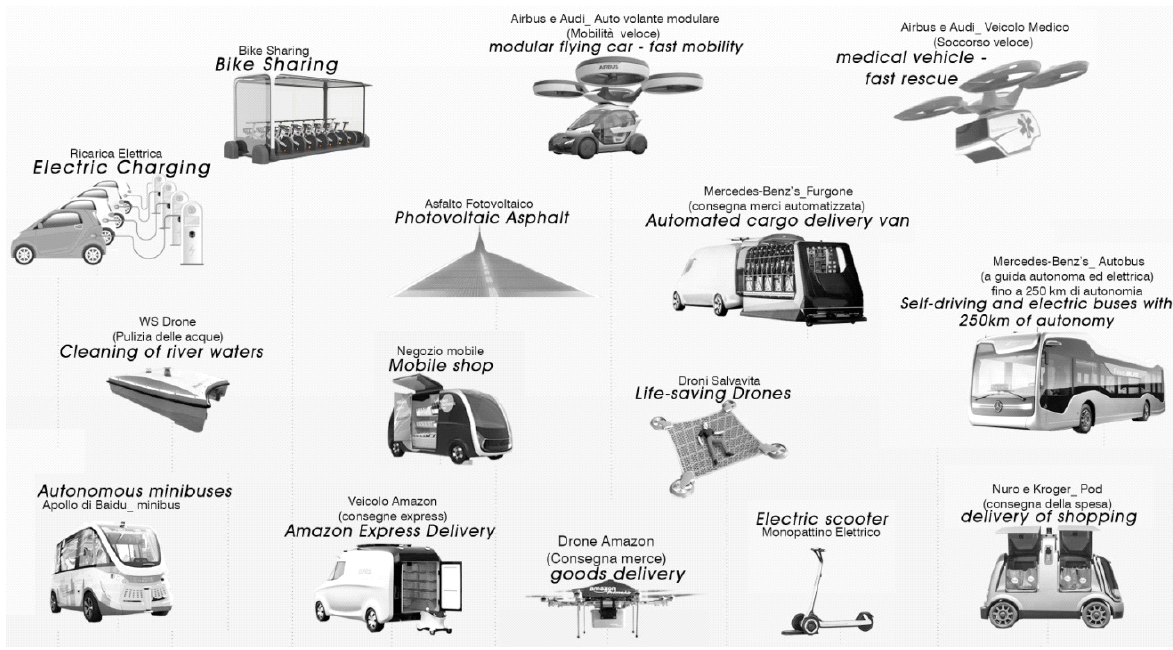
Figure 4 Smart Mobility systems, Florence School of Architecture,